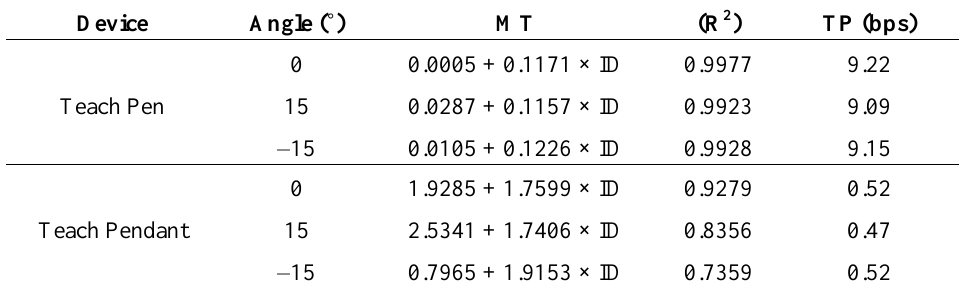
Table 2. MT equation, correlation, and TP of the two tools at three inclination angles.